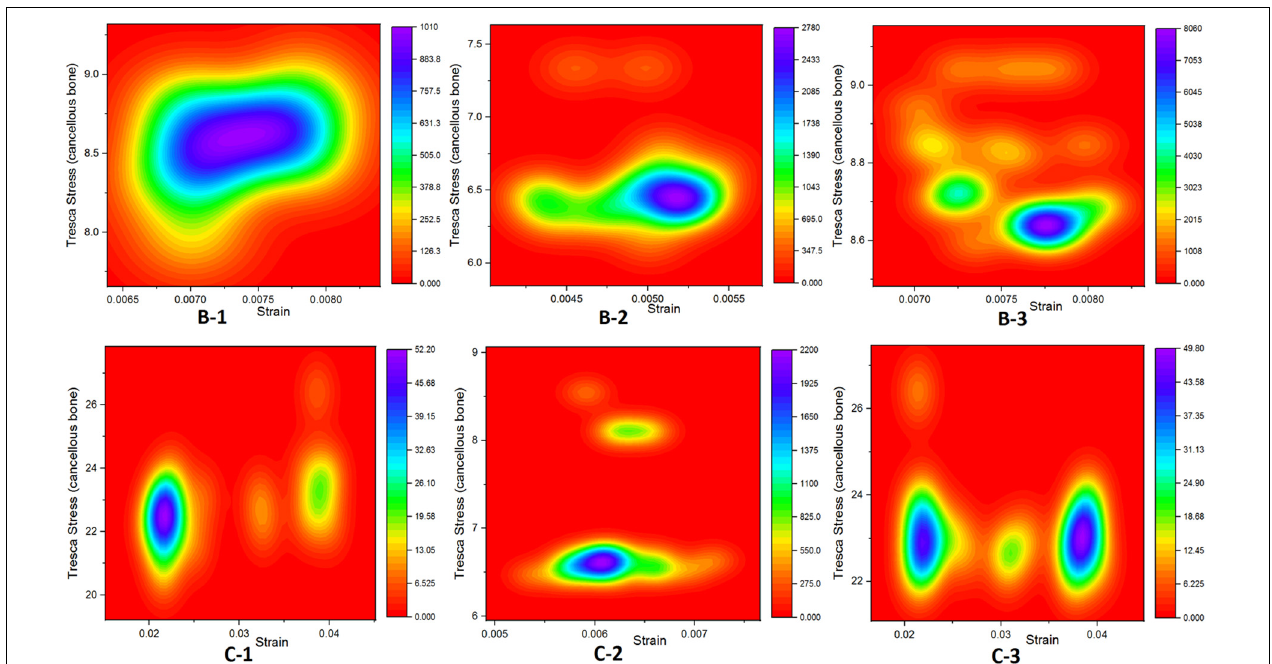
FIGURE 7 | Graphical representation relationship between cancellous bone stress (bone resorption) and